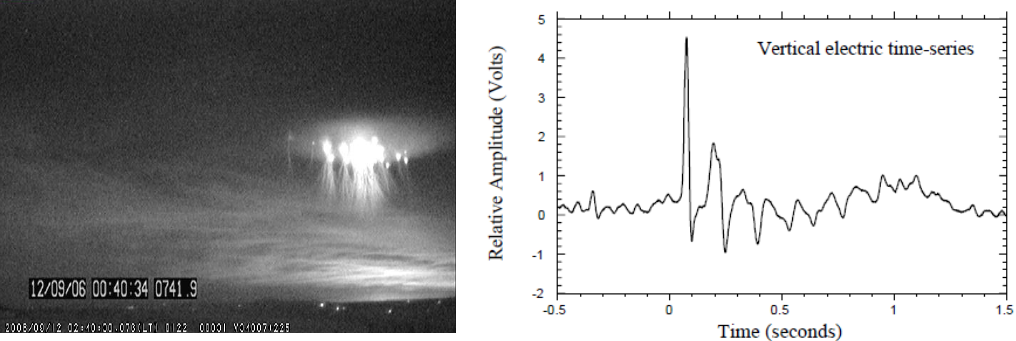
Figure 10 . A sprite observed by the ILAN team [138] together with a typical ELF transient, showing clearly the eight peaks per second (8 Hz) in the vertical electric field [29].